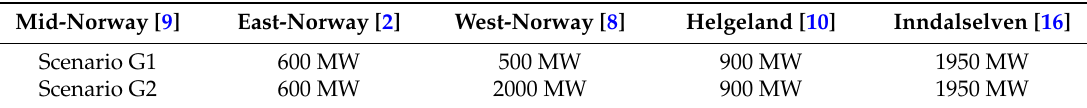
Table 1. Transmission line capacity scenarios between the Mid-Norway and its four neighbouring regions. Numbers in brackets refer to the market areas on Figure